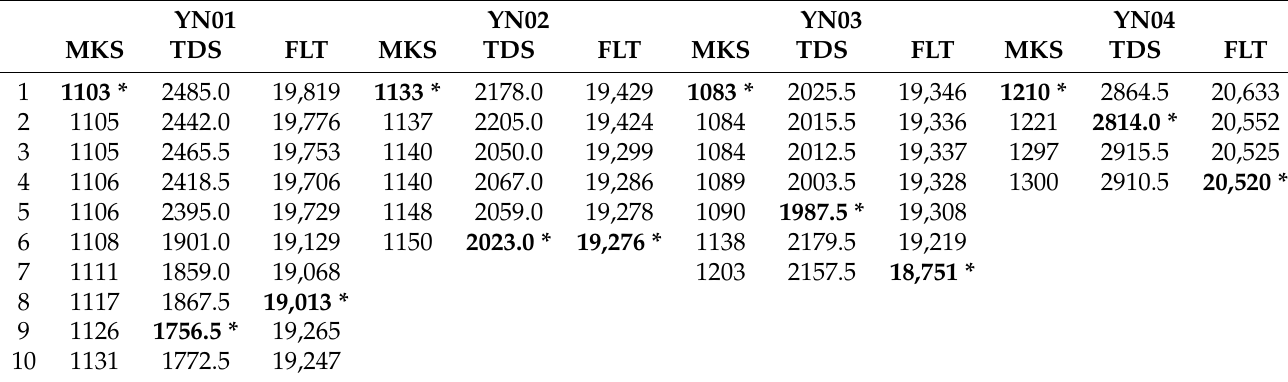
Table A5. Non-dominated front obtained by CMOSA for the JSSP instances proposed by [44].